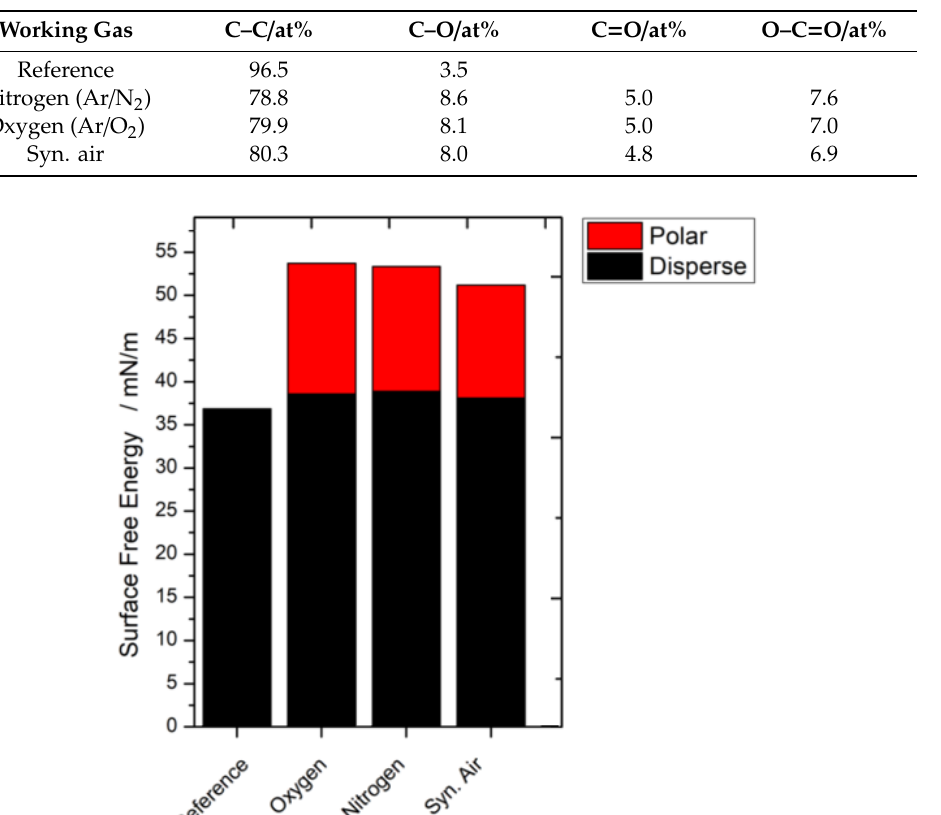
Table A1. XPS data of the C1s carbon peak from fitted Voigt profiles of PP60 before and after plasma treatment with different working gases.